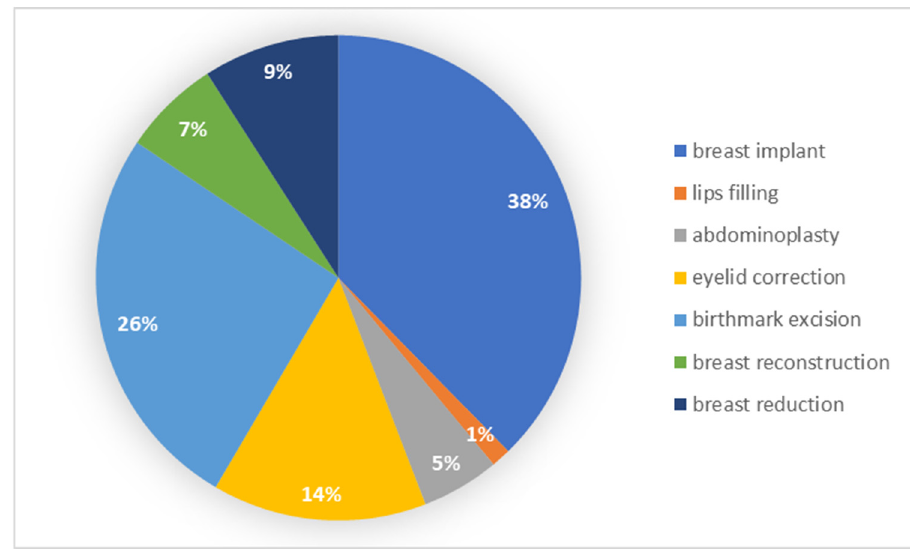
Figure 5. Types of procedures performed by patients with higher education.